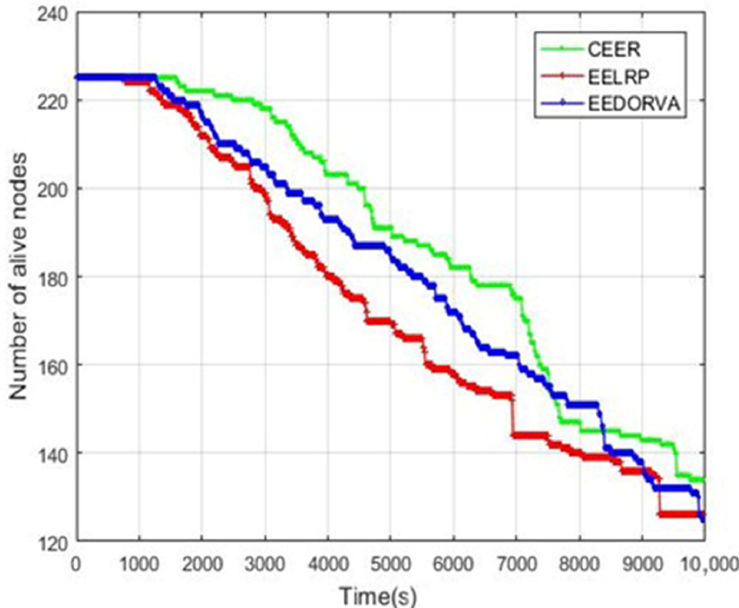
Figure 4. Alive nodes versus of network’s lifetime.